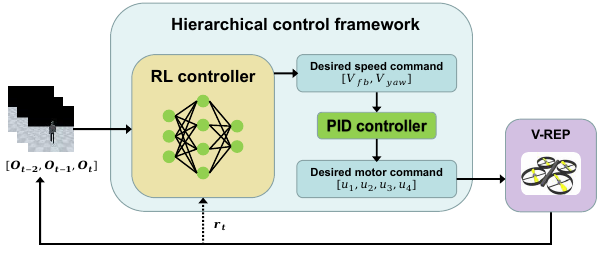
Figure 1. Hierarchical control framework for the quadrotor active tracking